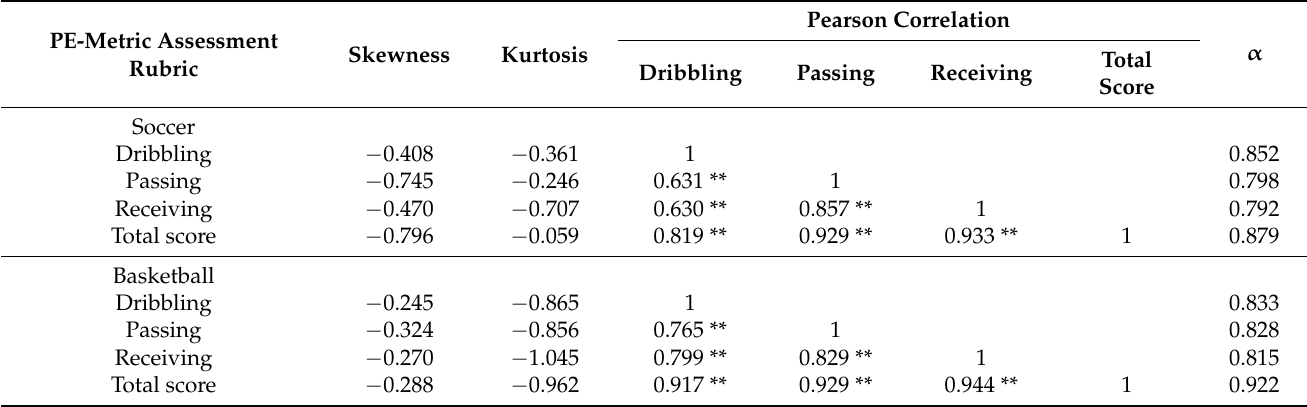
Table 1. Descriptive statistics, Pearson’s correlations, and alpha coefficients of the manipulative skill assessments. PE-Metric